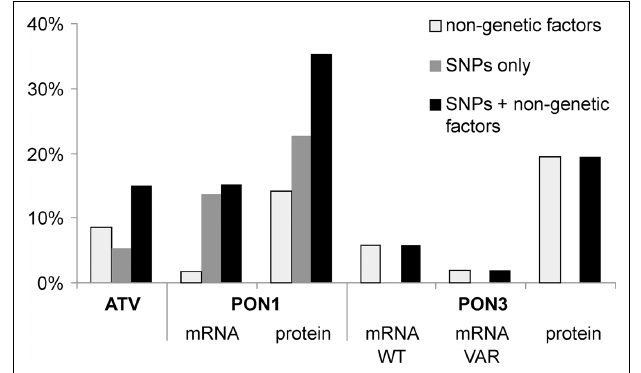
FIGURE 8 | Percentage of total atorvastatin-lactone hydrolysis, PON1, and PON3 expression variation explained by multivariate linear models containing only non-genetic factors (white), only genetic factors (gray), or both (black). The bars indicate the coefficient of determination adjusted for the number of factors in the different models. Linear models were derived by step-wise model selection procedure using Akaike’s information